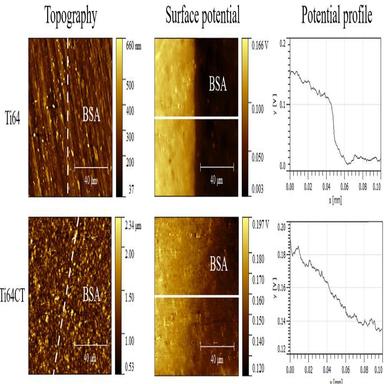
Atomic force microscopy of Ti64 (top) and Ti64CT (bottom) surfaces half covered with BSA. Scan size is 100x80 lm. Left: AFM topographical images, the white dotted lines represent the border of the BSA layer; center: KPFM surface potential images of the same area; right: potential profiles along the white line on the potential images.